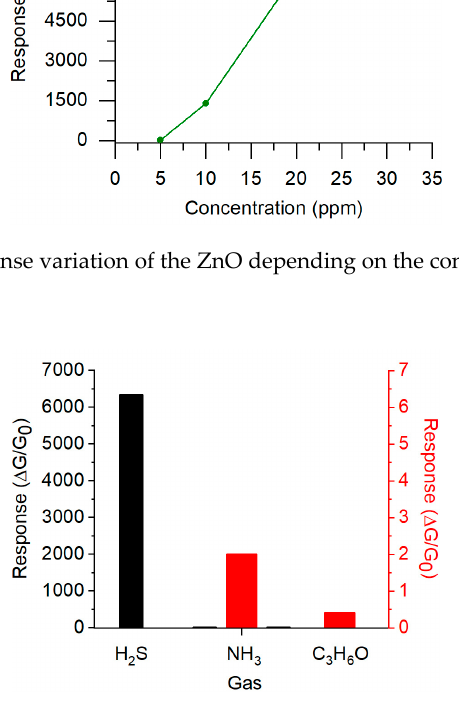
Figure 3. Response of the ZnO towards 20 ppm of H 2 S, NH 3 and C 3 H 6 O at 400 °C.